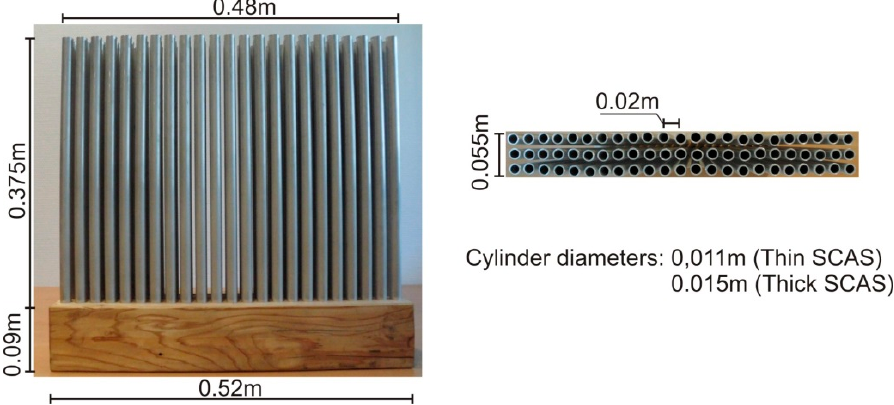
Figure 6. Front and plan view of the scaled SCASs.